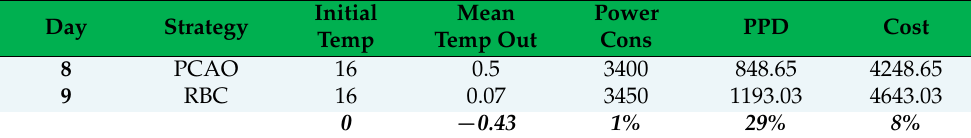
Table 16. Comparison between the PCAO (8th) and RBC (9th) winter days.